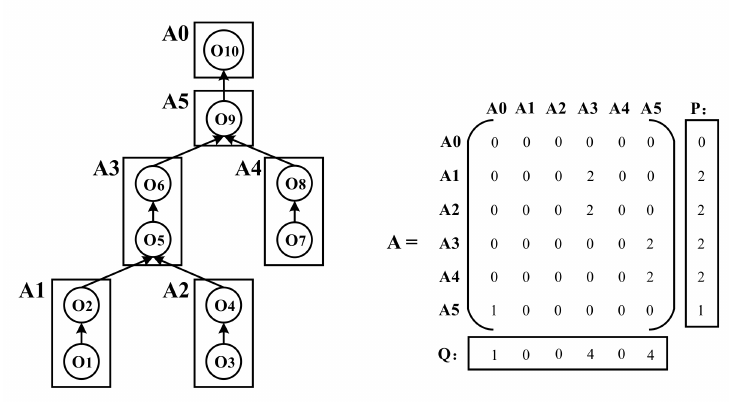
Figure 4. Adjacency matrix of product A.